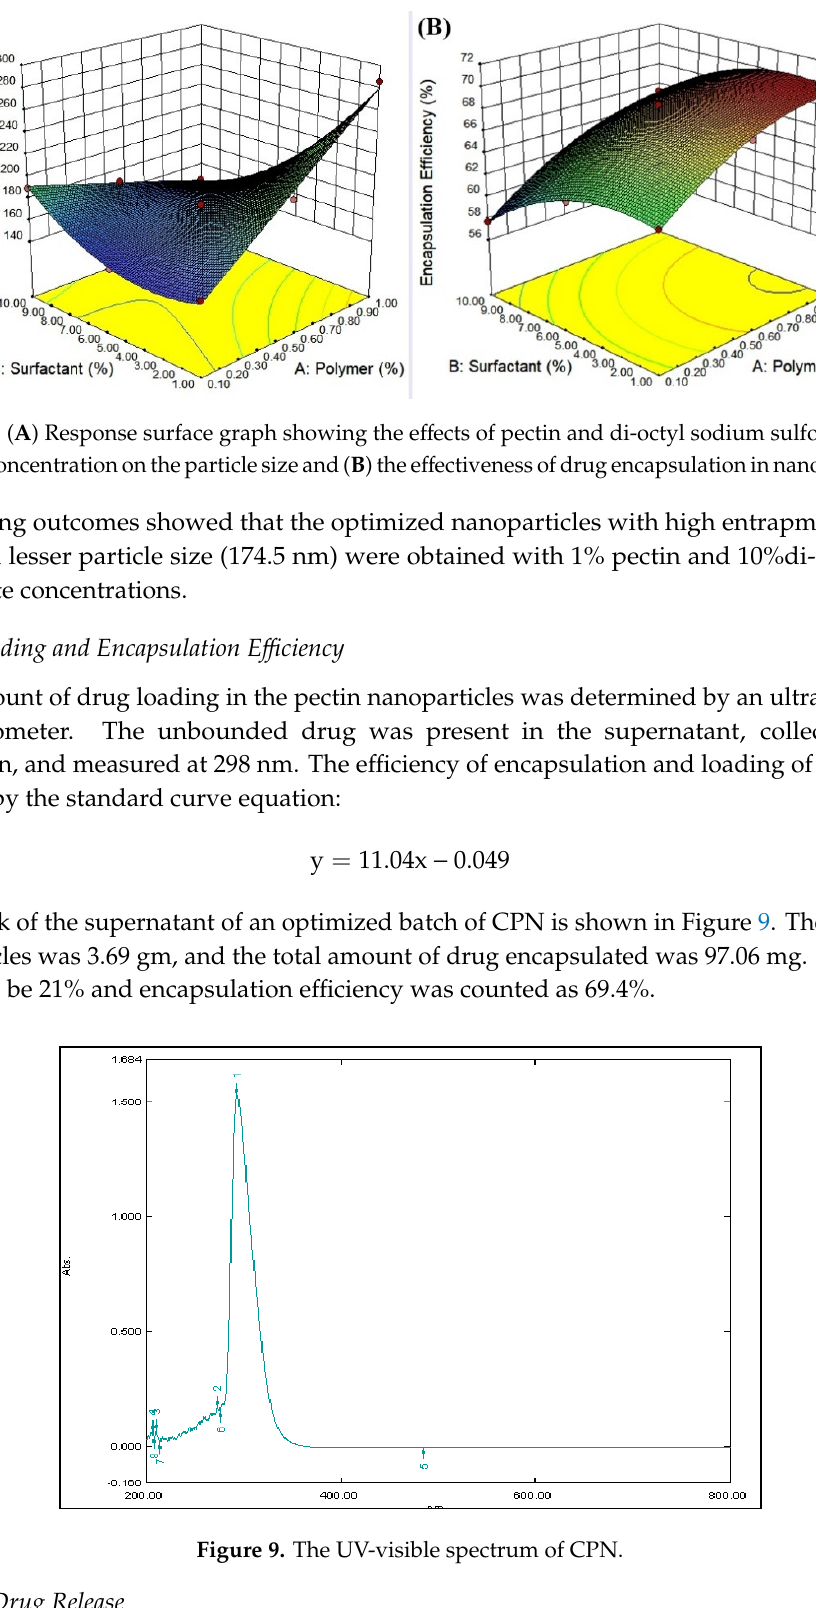
Figure 9. The UV-visible spectrum of CPN.